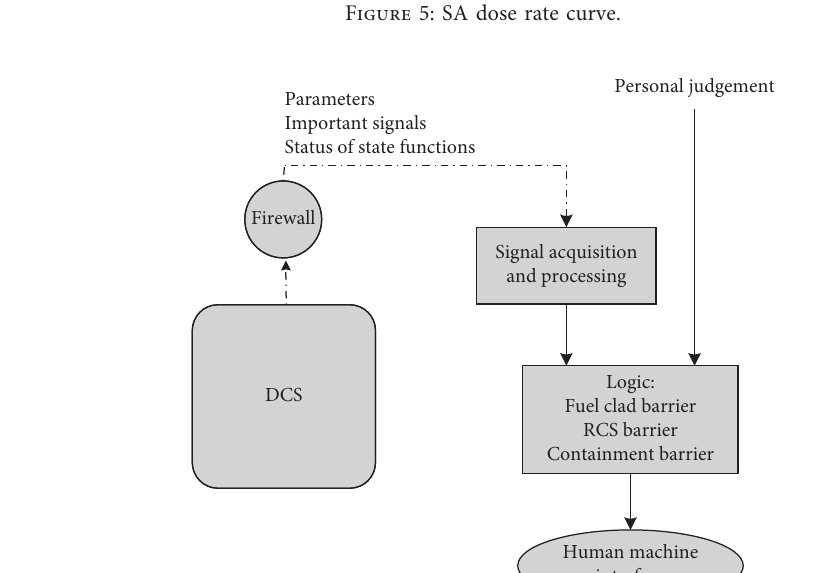
Figure 6: Interface with